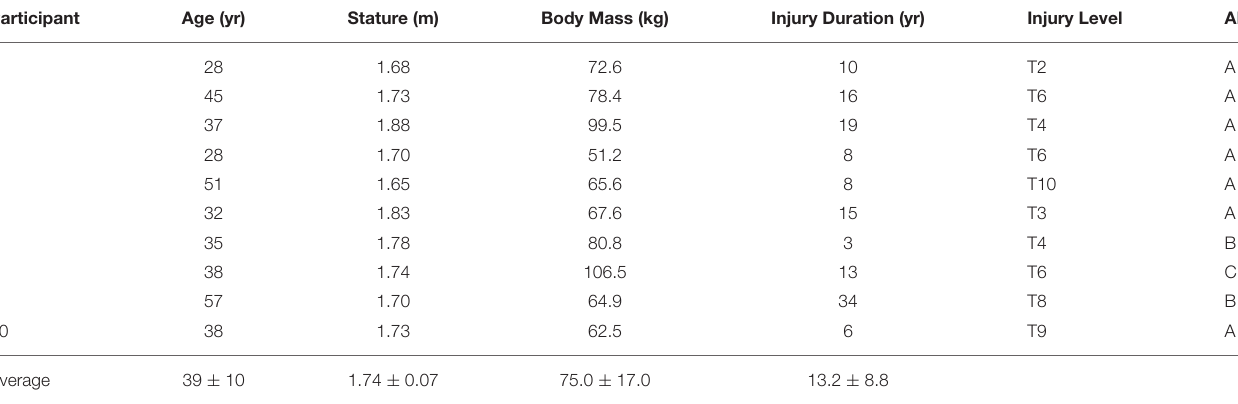
TABLE 1 | Participant